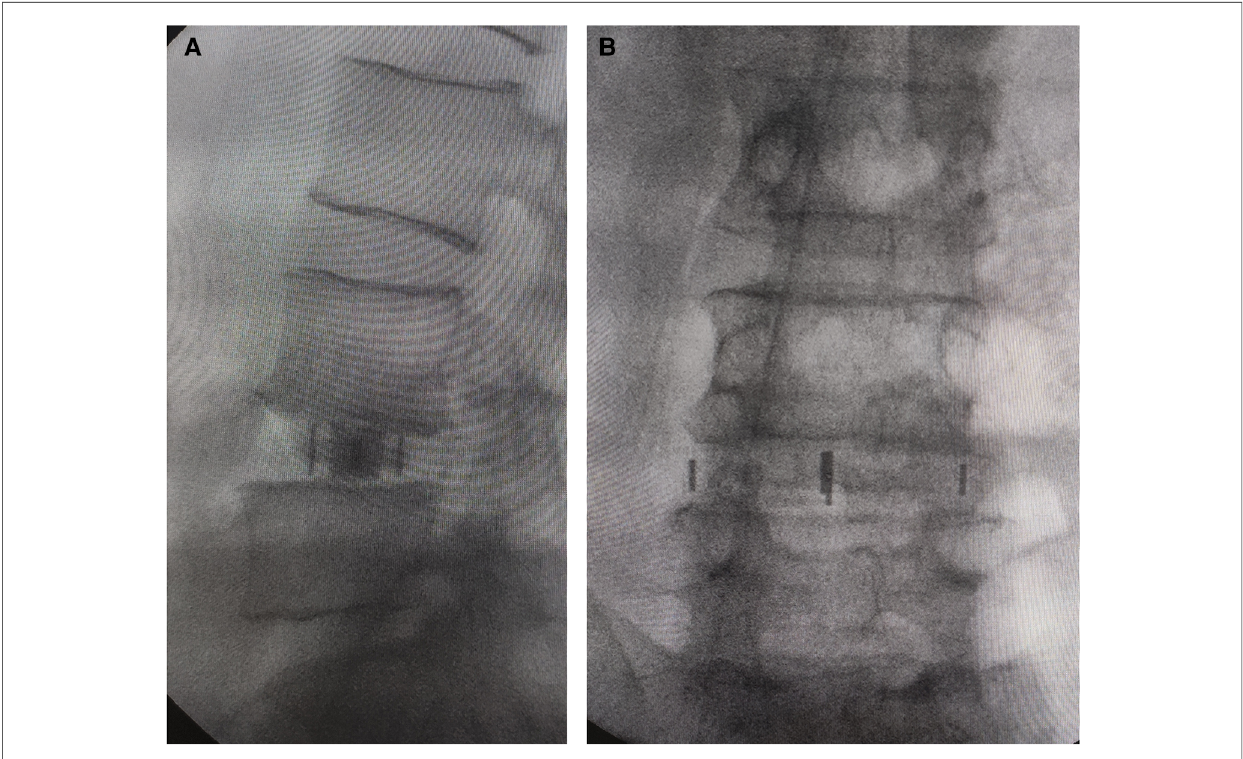
FIGURE 7 ( A ) Intraoperative anteroposterior and ( B ) lateral radiographs to con fi rm the ideal position of the cage. Anteroposterior and lateral metal markers show the cage was almost perpendicular to the spine. ( A ) Anteroposterior metal markers show the cage extending the entire width of the disc and vertebral body with support from the lateral aspect of the vertebral body